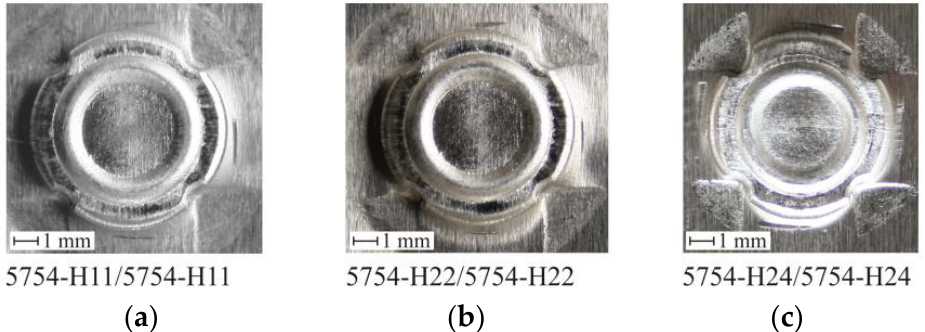
Figure 8. The embossments obtained during the joint forming process for identical materials of the top and bottom sheets. Sheet arrangement in accordance with Table 2: ( a ) no.1, ( b ) no.4, ( c ) no.7. In all other arrangements of sheet material, for which the lower sheet was made of